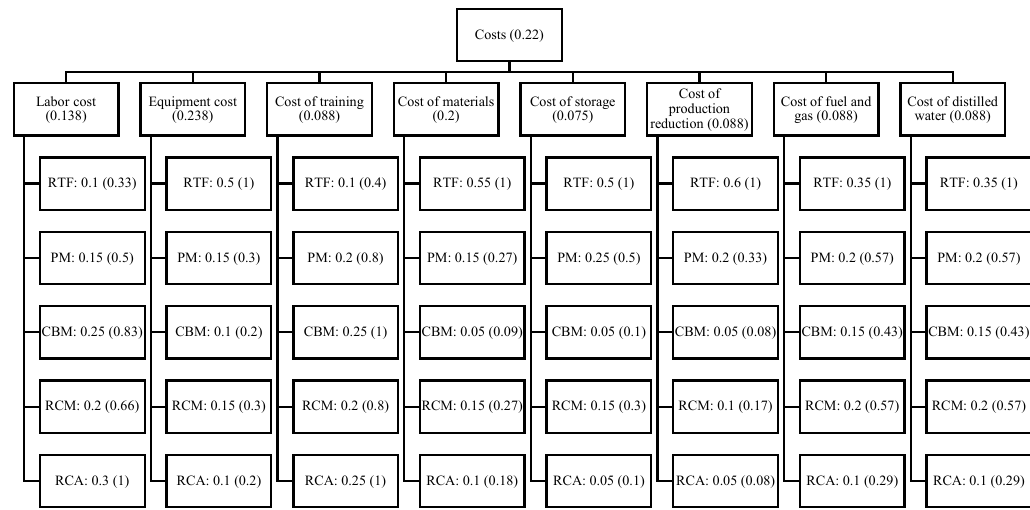
Fig. 5. Hierarchy chart of evaluated costs and alternatives